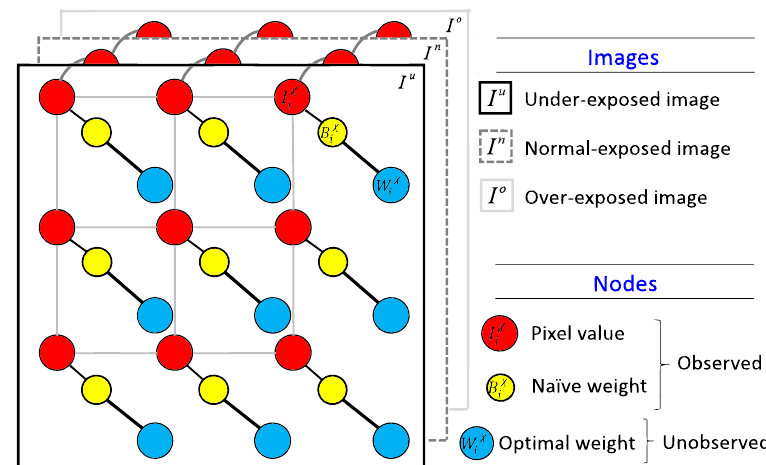
Figure 1. Undirected graph representation of the multivariate normal conditional random fields (MNCRF) model, where the blue nodes denotes the unknown desired random variables (RVs) in terms of the fine-tuned weights, the red nodes denotes the observable RVs in terms of the pixel values, and the yellow nodes denotes the observable RVs in terms of the naïve weights.